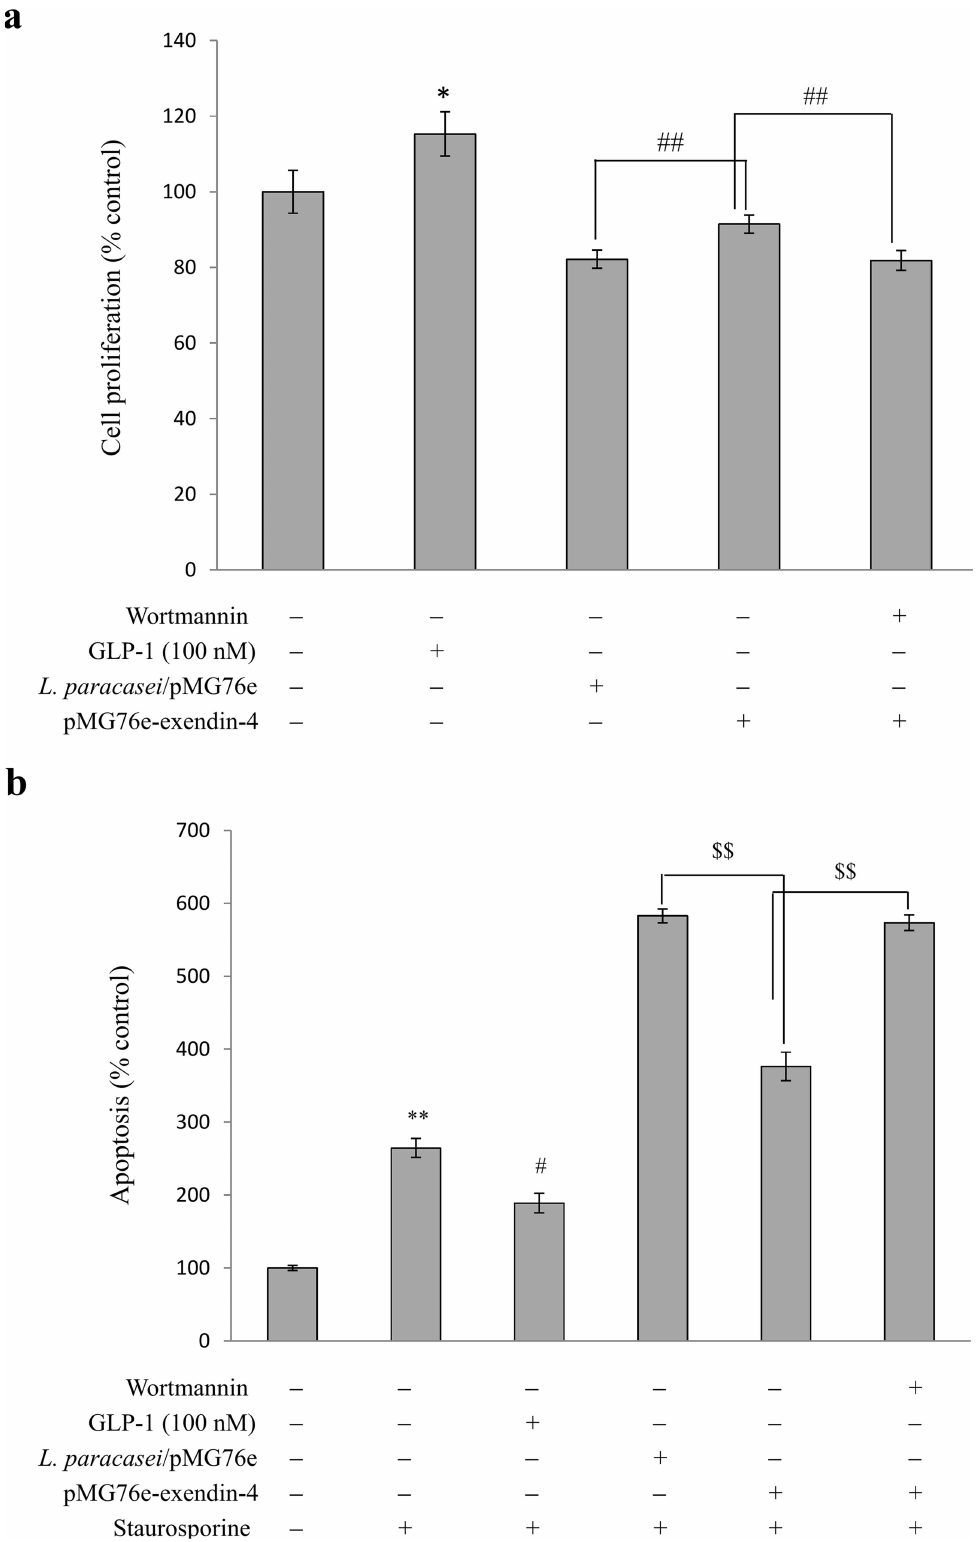
Fig 5. Effect of recombinant exendin-4 on proliferation and staurosporine-induced apoptosis of INS-1 cells. (a) INS-1 cells were preincubated with media alone or with 100 nmol/l wortmannin, followedby